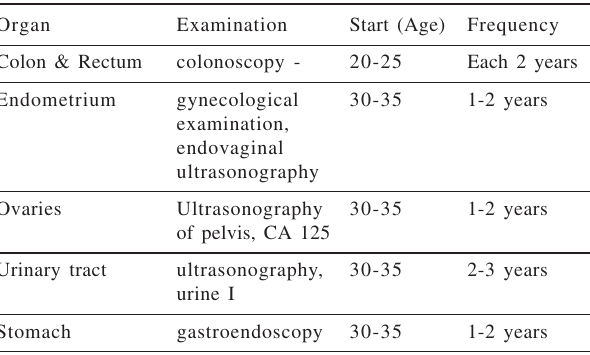
Table 3 - Guidelines recommended by ICG-Hereditary nonpolyposis colorectal cancer for preventive examinations and early diagnosis of colorectal cancer and extracolic tumors 25